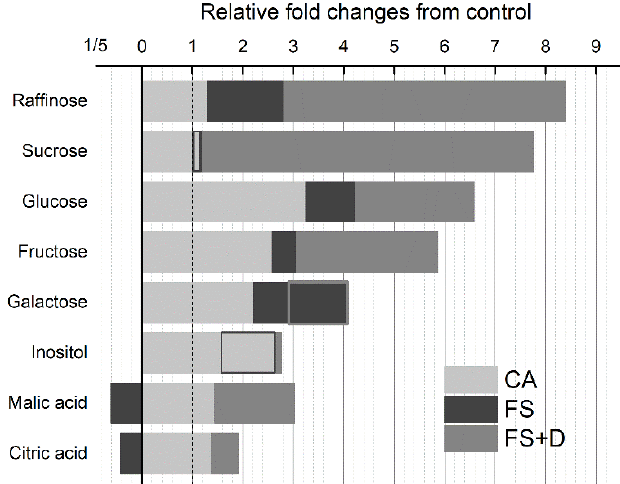
Figure 6. Changes in the mean concentration of carbohydrates and organic acids measured in leaves of Haberlea rhodopensis from the control under ex situ environmental conditions. Light grey bars indicate changes between control (May) and cold acclimation (CA; period 07 – 28 November). Dark grey bars indicate changes from CA to short-term exposure to freezing temperatures (FS; −1 0 C, 30 November). Grey bars indicate changes between FS and longer-term exposure to freezing temperatures when significant desiccation occurred (FS + D; period: 05 – 14 December). The bars for compounds for which the trend between one phase was opposed to that observed during the precedent transition have only the grey outlines.